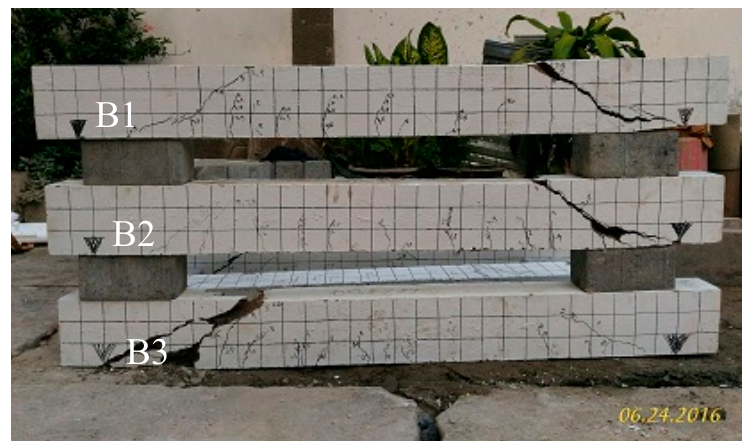
Figure 7. Crack pattern of the series I test (B1, B2, and B3).